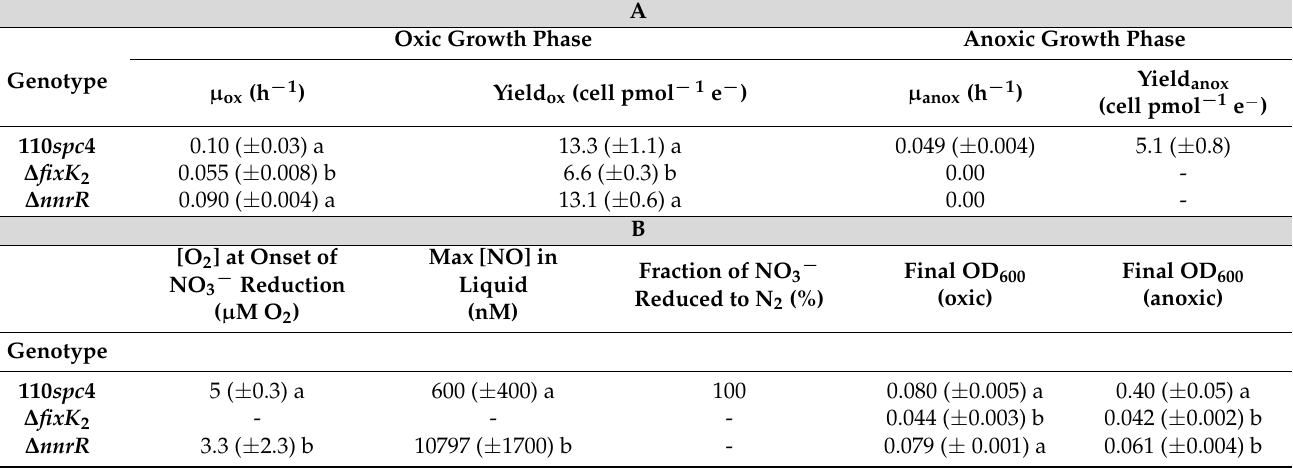
Table 1. Summary of growth parameters from O 2 (oxic growth phase) and NO 3 − respiration